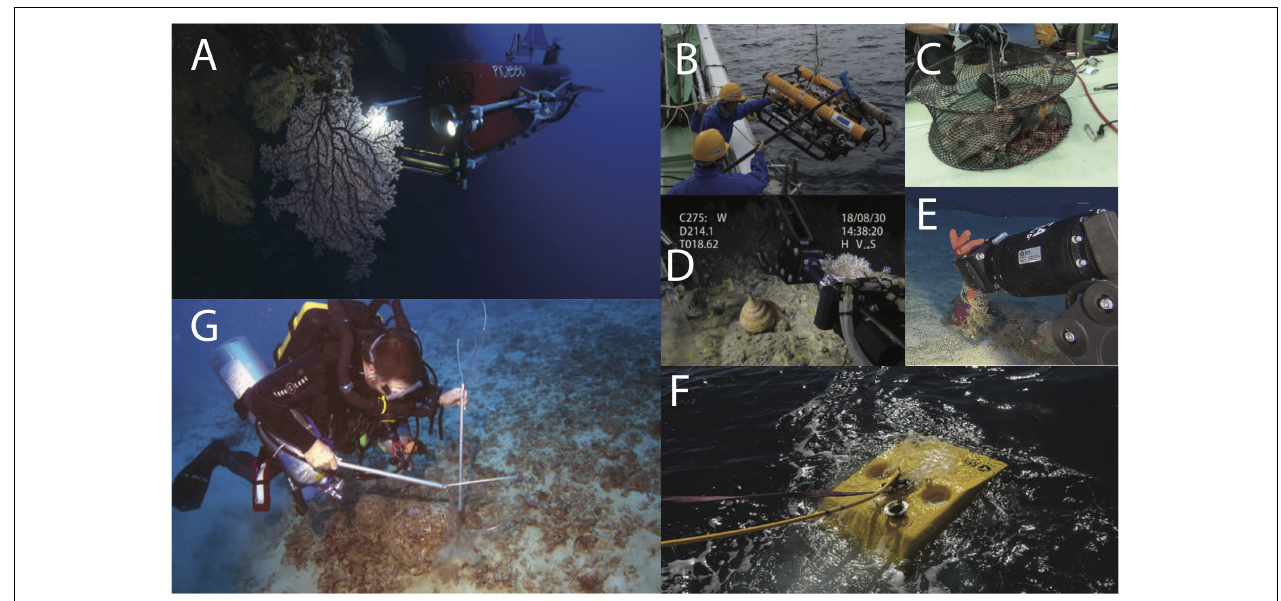
FIGURE 1 | Various methods of sampling employed in this study, including (clockwise) (A) PICASSO ROV (JAMSTEC) in situ acquiring high-resolution video; (B) Okinawa Churaumi Aquarium ROV external view during recovery; (C) An Okinawa Churaumi Aquarium baited trap; (D) Okinawa Churaumi Aquarium ROV frame grab from in situ sampling, (E) ROV (ECA H800) frame grab from in situ sampling in Eilat, Red Sea, Israel; (F) ECA H800 during recovery, and (G) J. Copus during rebreather surveys in Okinawa, Japan at 80